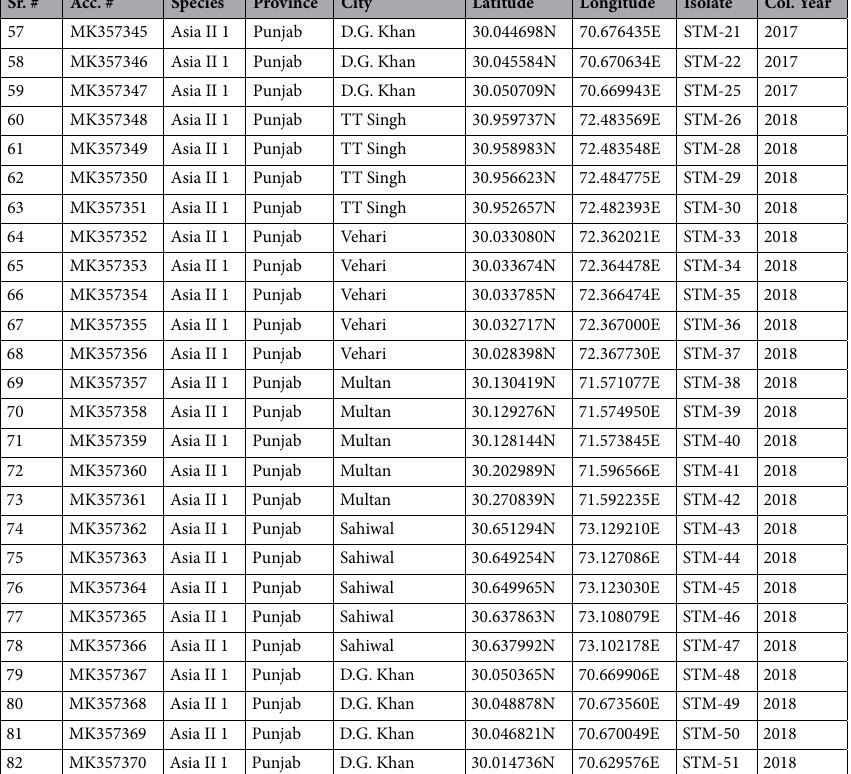
Table 1. Detail of B. tabaci sequences identified in the current